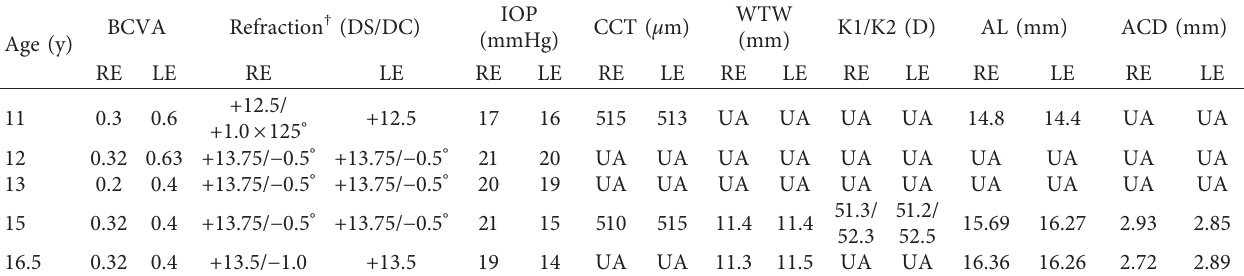
Table 1: Ophthalmic examination results of individual V:1 with nanophthalmos caused by a homozygous variant in PRSS56 . BCVA Age (y)